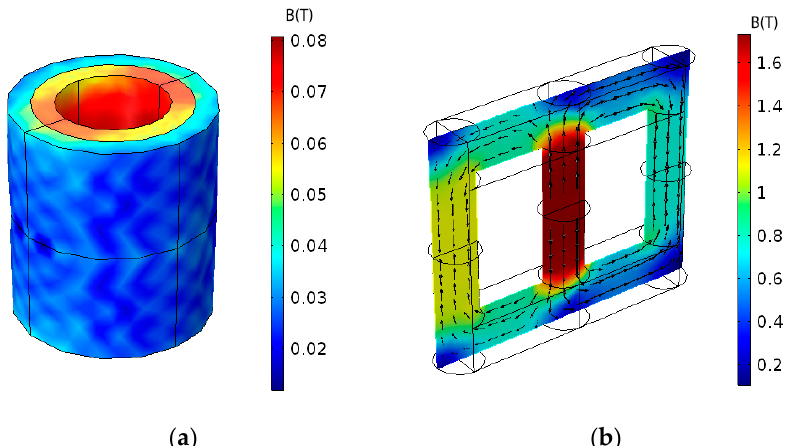
Figure 9. ( a ) Flux-density distribution of the transformer winding; ( b ) Flux-density distribution of the transformer iron core.